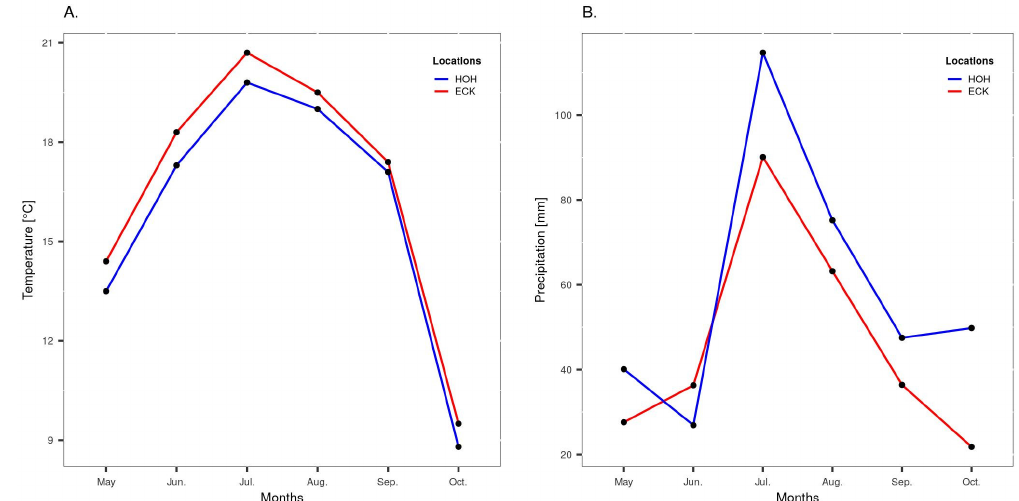
Figure 1. Monthly mean values of ( A ) temperature (°C) and ( B ) precipitation (mm) belong to the experimental locations between May–October 2016 (Agrarmeteorologie Baden-Württemberg, 2016).